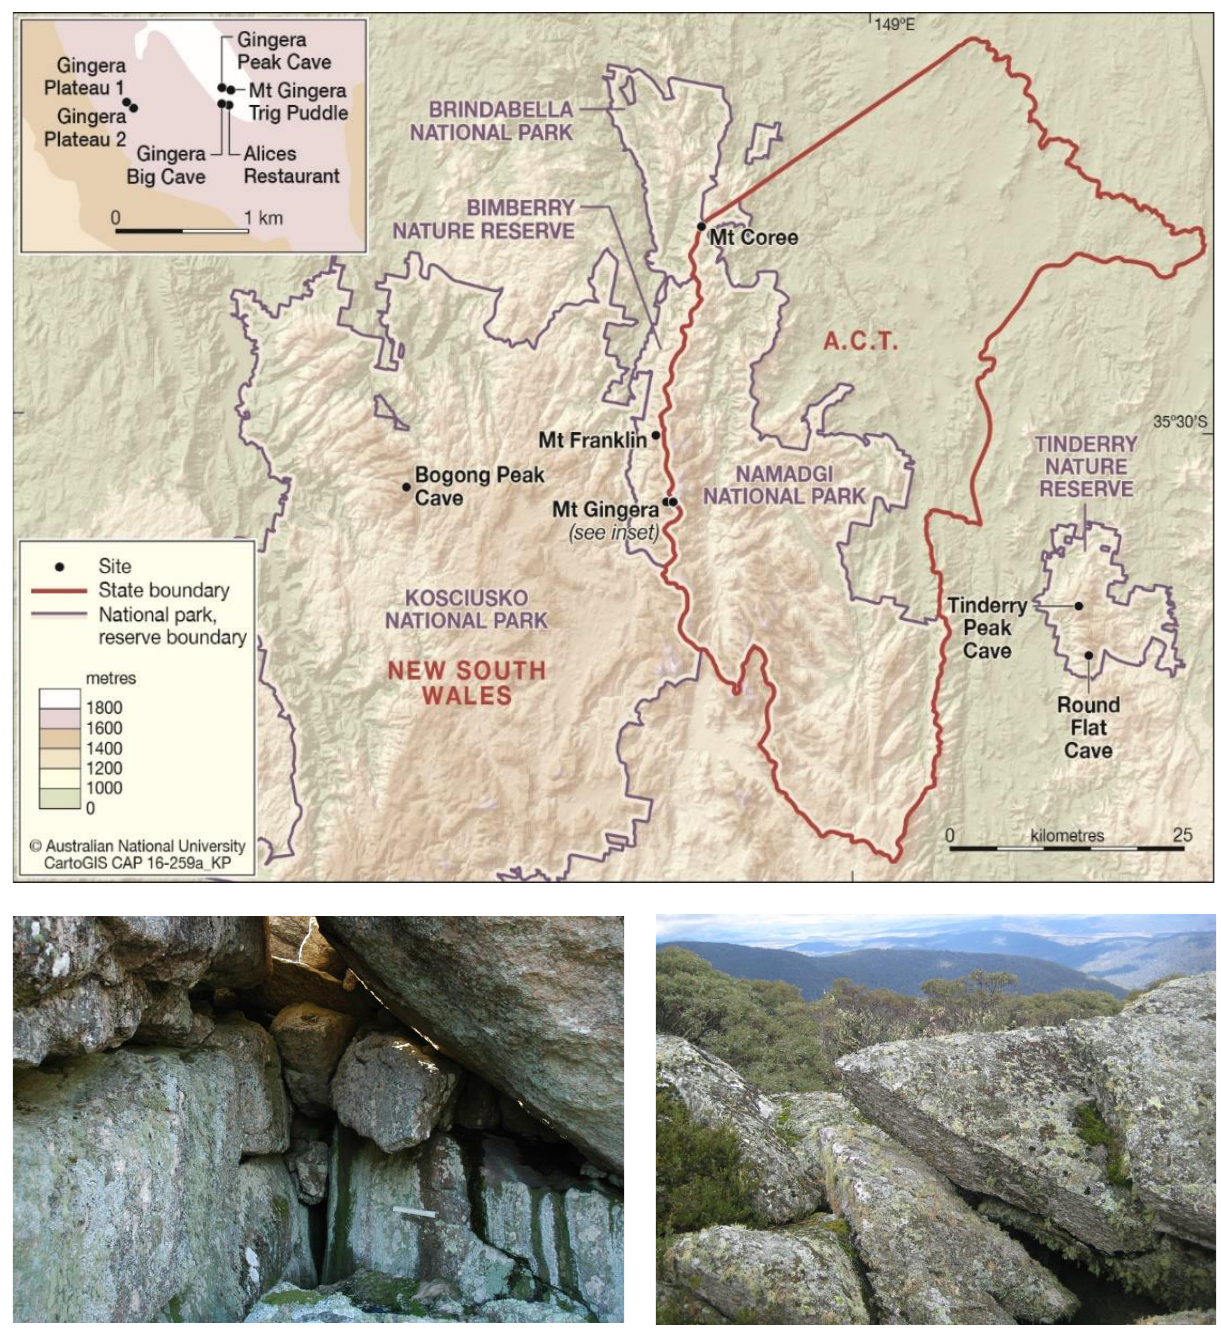
Figure 2. Above: map of the northern part of the Australian Alps showing the locations of study sites. Below: two of the boulder-pile study sites, at Bogong Peaks (left; note the 50 cm section of PVC tubing for scale) and on Mount Gingera